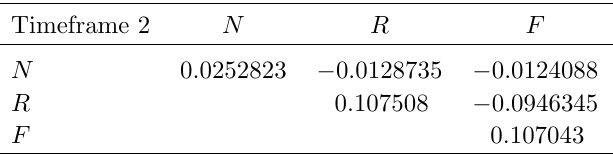
Table A.2. Covariances between different variables of timeframe 2 for renewable countries (nuclear countries included).